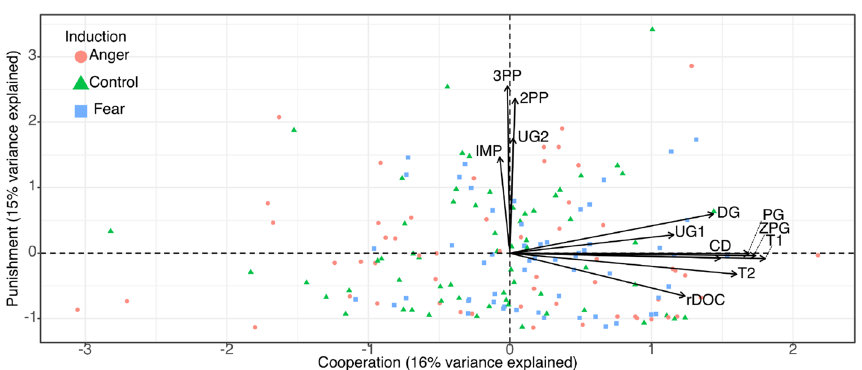
Figure 3. Factor analysis bi-plot. 2 factors, labeled “Cooperation” and a “Punishment”, explain nearly one third (31%) of the variance from 12 different decision